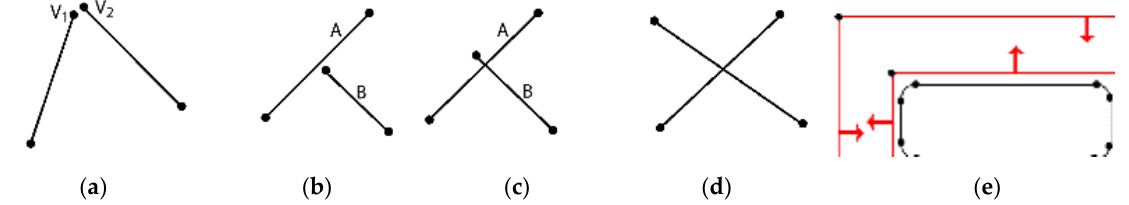
Figure 5. ( a ) Two points are close to each other and are merged. ( b , c ) Line A is split since another endpoint is close to the line. ( d ) Crossings are left untouched. ( e ) All line segments are added with vectors showing to the inside of the element.